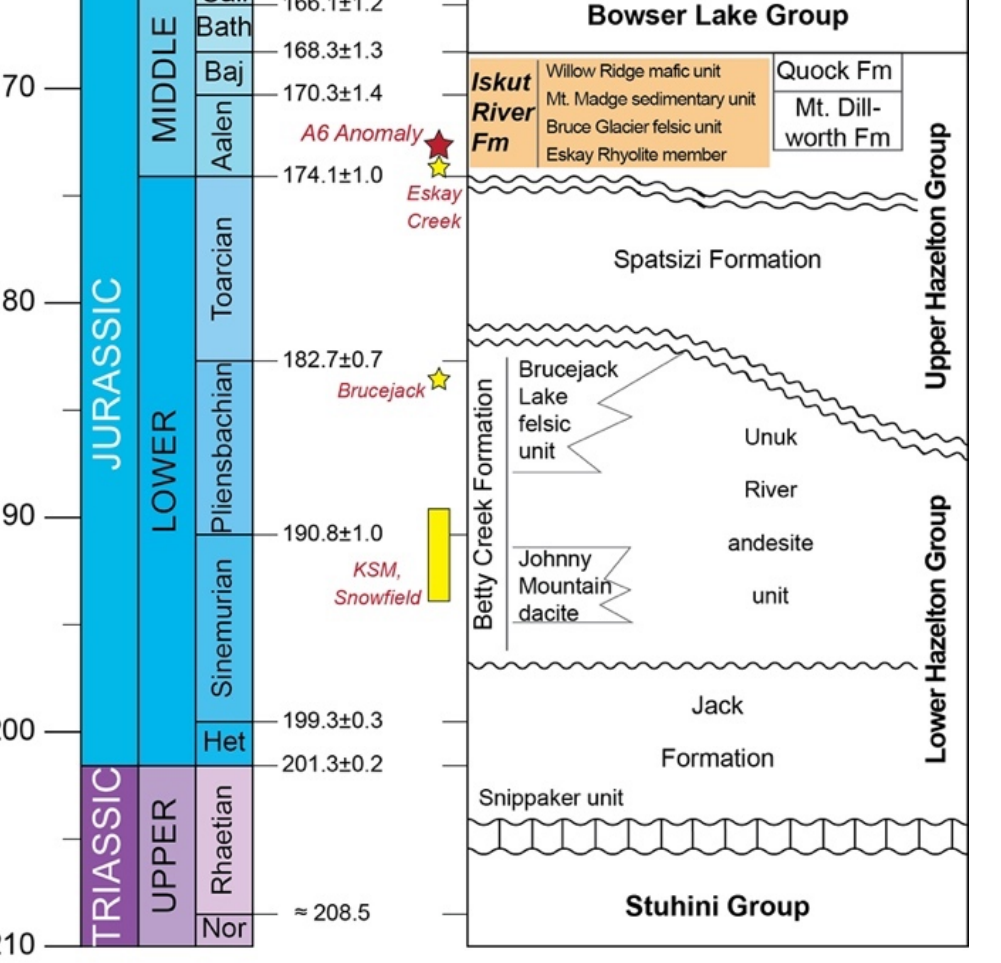
Figure 2. Stratigraphy of the Hazelton Group in the Iskut River area. Yellow stars and bar show the age of the deposits in this region, while the red star shows the U-Pb zircon age of altered felsic flows at the A6 Anomaly, Iskut River Formation (light orange is the stratigraphic level of interest in this study); see Table 1 for more detailed information on the age of mineral deposits, modified after Nelson et al. [6], with a stratigraphic chart after Cohen et al. [32]. Abbreviations: Baj—Bajocian, Bath—Bathonian, Call—Callovian, Fm—Formation, Het—Hettangian, Nor—Norian.